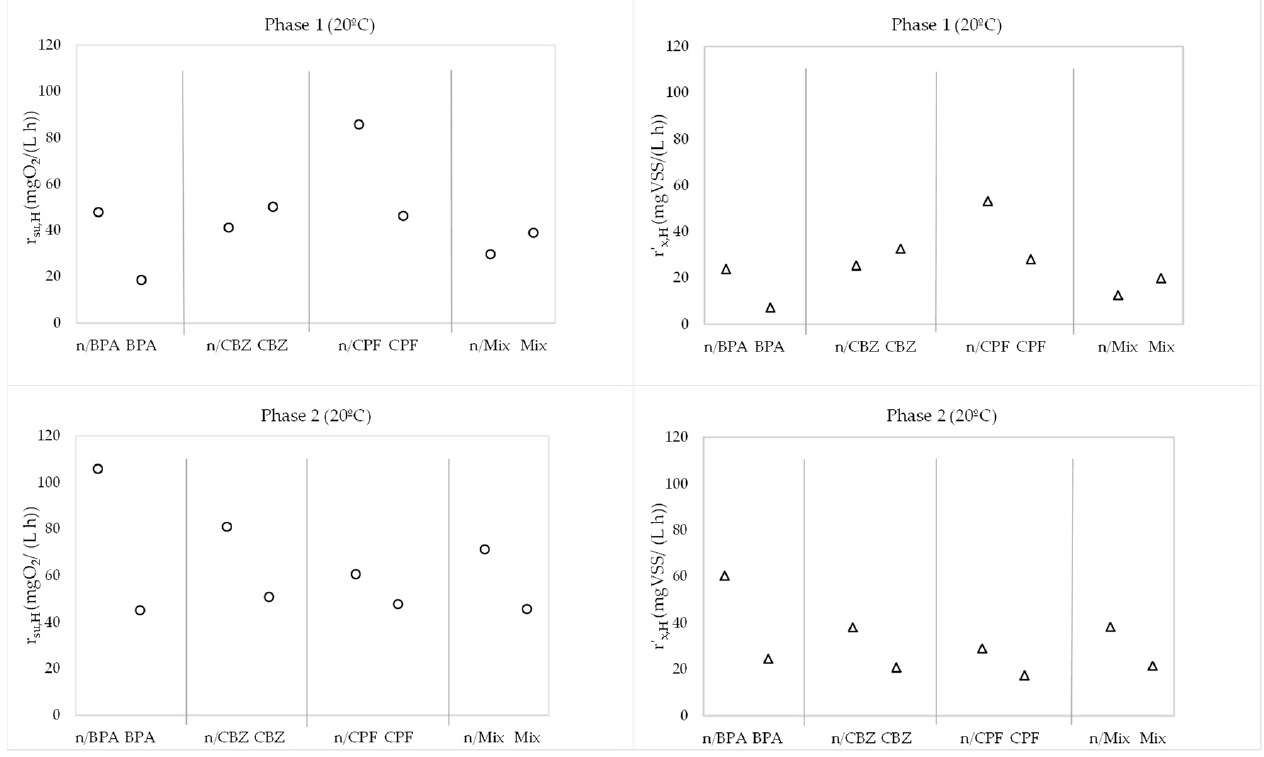
Figure 8. Evolution of r su,H ( ◦ ) and r ’x,H ( Δ ) in phase 1 and phase 2 at 20 °C. n/BPA: absence of bisphenol A. BPA: presence of bisphenol A. n/CBZ: absence of carbamazepine. CBZ: presence of carbamazepine. n/CPF: absence of ciprofloxacin. CPF: presence of ciprofloxacin. n/Mix: absence